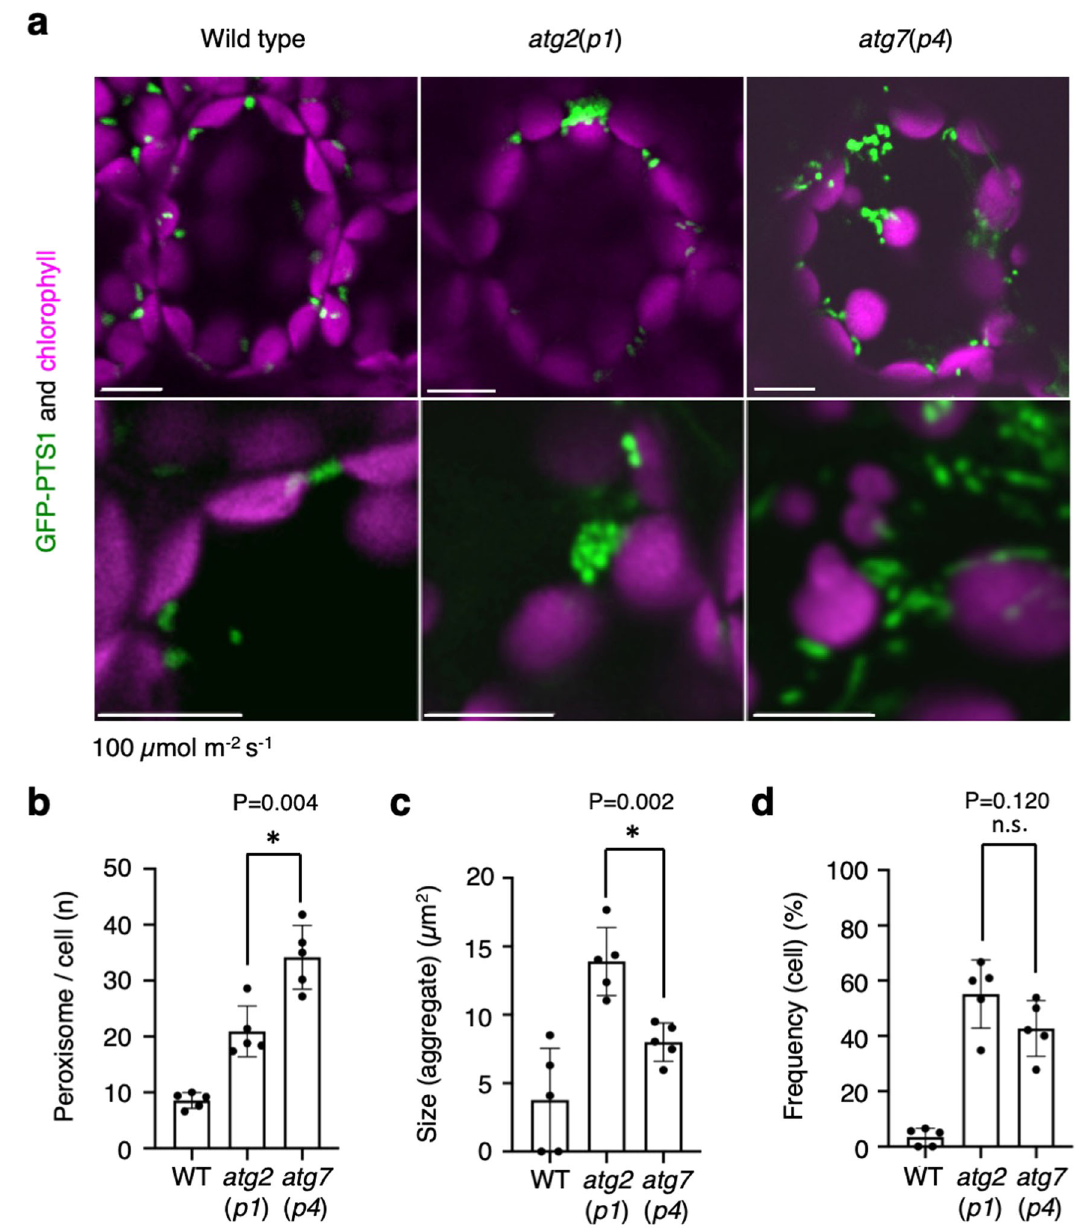
Fig. 1 | Difference in phenotypes of peroxisome aggregates between atg2 ( p1 ) and atg7 ( p4 ). a Peroxisomes (GFP-PTS1, green) and chloroplasts (auto- fl uorescence, magenta) in leaf mesophyll cells of wild type (WT), atg2 ( p1 ), and atg7 ( p4 ). The bottom images are enlarged images of peroxisome aggregates. Images are obtained from the surface to middle depth region of 3-week-old plants culturedon anagarplate containing ½ MS with1%sucrose under normal-intensity (100 μ molm − 2 s − 1 ) white-light conditions. Scale bars, 10 µ m. b Peroxisome number